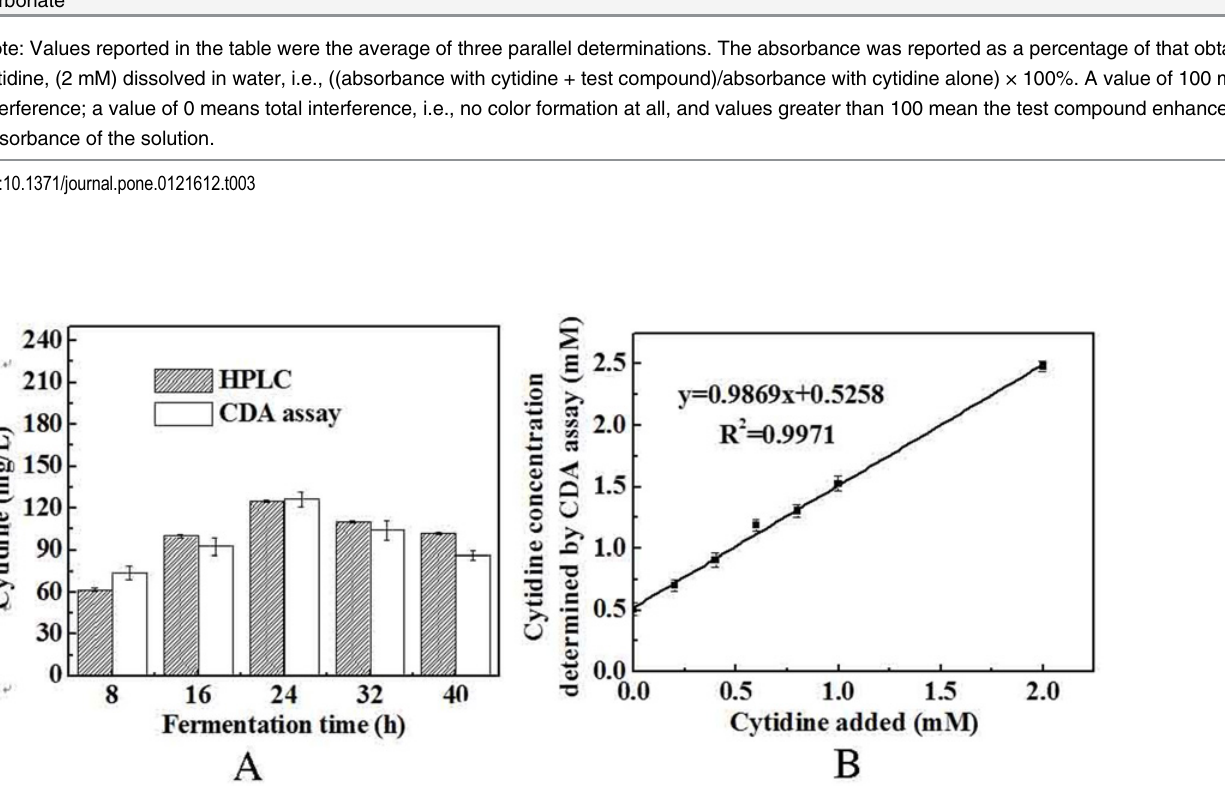
Table 3. Effect of medium components on the cytidine assay. Compound Concentration (mM) Mineral salts Amino